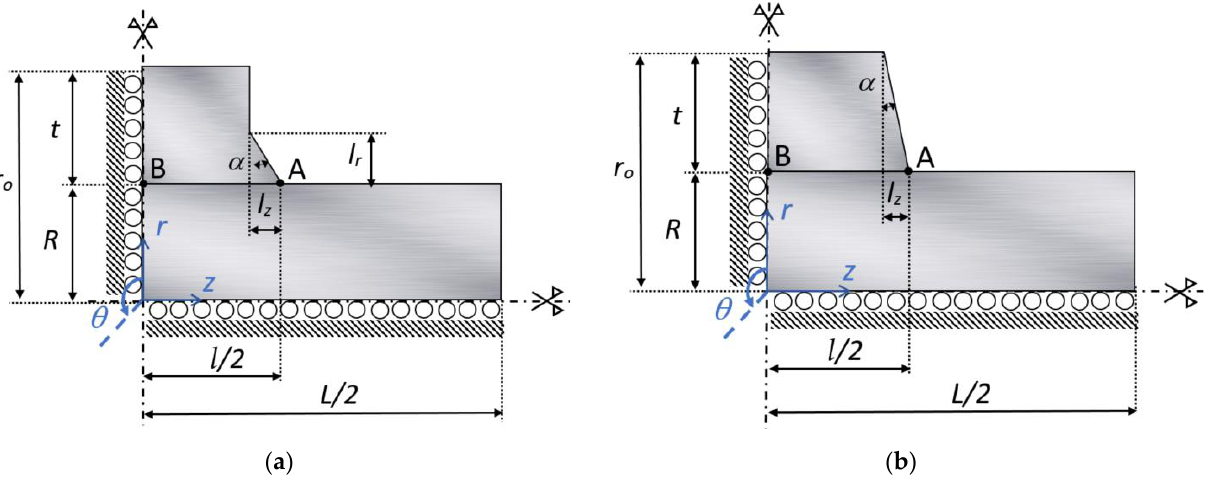
Figure 3. Scheme of two – dimensional finite element modeling of the interference fit with ( a ) a partial – chamfer hub and ( b ) a full – chamfer hub. Point A is located at the hub edge and point B is placed at the half cross section of the hub at the interface.